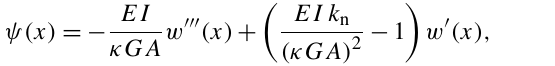
Figure 2. Snowpack modeled (a) as a beam on an elastic founda- tion of an infinite set of shear and compressive springs (b) using Timoshenko beam kinematics.